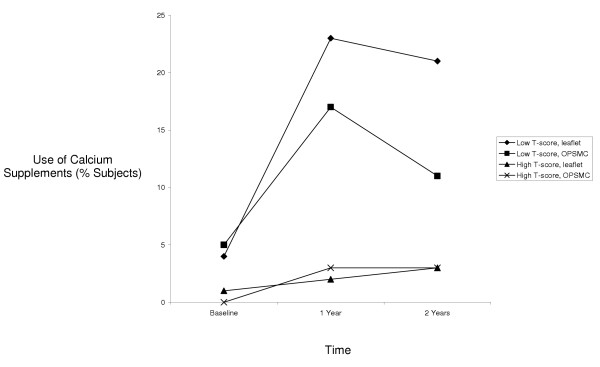
Calcium supplement use by intervention group. This shows changes in calcium supplement use by subjects in each of the four intervention groups over the study period. Only those intervention groups that included feedback of low T-score had significant increases in calcium supplement use.